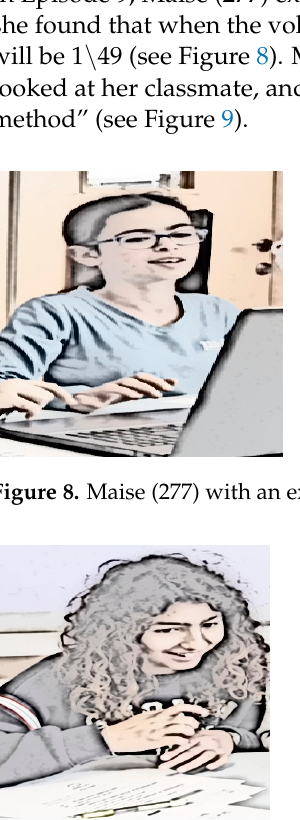
Figure 9. Lean (278) knocked on the table,